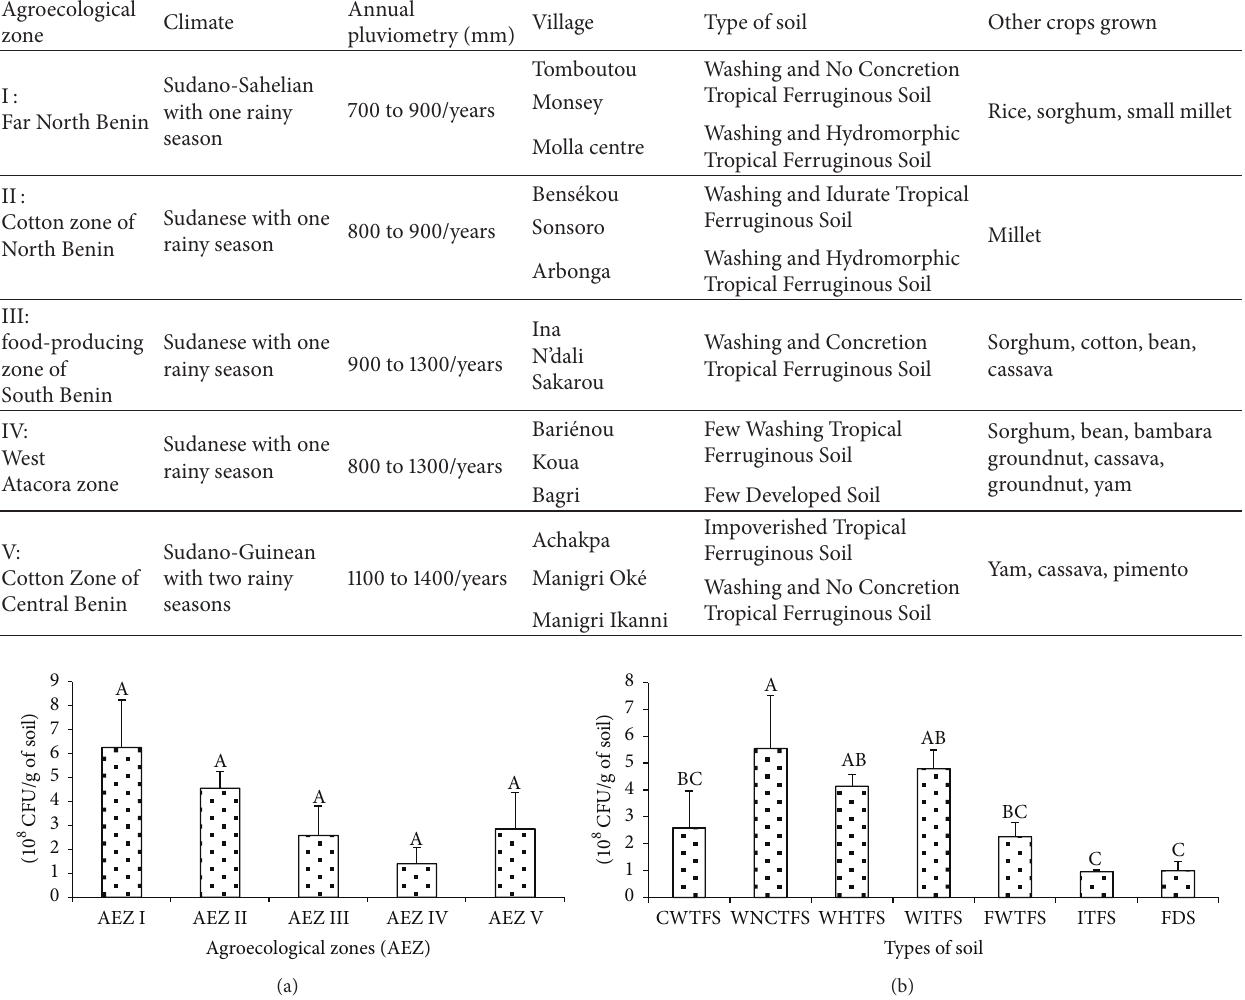
Figure 2: Distribution of aerobic mesophilic flora according to (a) AEZ and (b) type of soil. WCTFS: Washing and Concretion Tropical Ferruginous Soil; WNCTFS: Washing and No Concretion Tropical Ferruginous Soil; WHTFS: Washing and Hydromorphic Tropical Ferruginous Soil; WITFS: Washing and Idurate Tropical Ferruginous Soil; FWTFS: Few Washing Tropical Ferruginous Soil; ITFS: Impoverished Tropical Ferruginous Soil; FDS: Few Developed Soil. The means with different letters are significantly different with probability level of 5% according to Student-Newman-Keuls